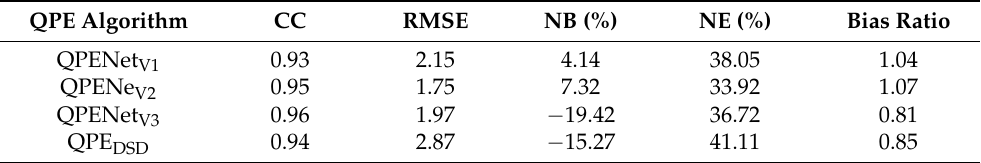
Evaluated scores for four kinds of QPE algorithms for the Merbok event for all rainfall intensities.